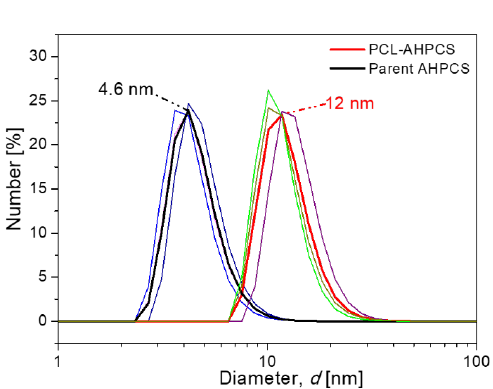
Figure 12. Colloidal size distributions determined by dynamic light scattering for parent AHPCS and pre-cross-linked AHPCS (PCL – AHPCS). The bold lines represent the average of the same sam- ple. Reprinted from [73] with permission from Elsevier.